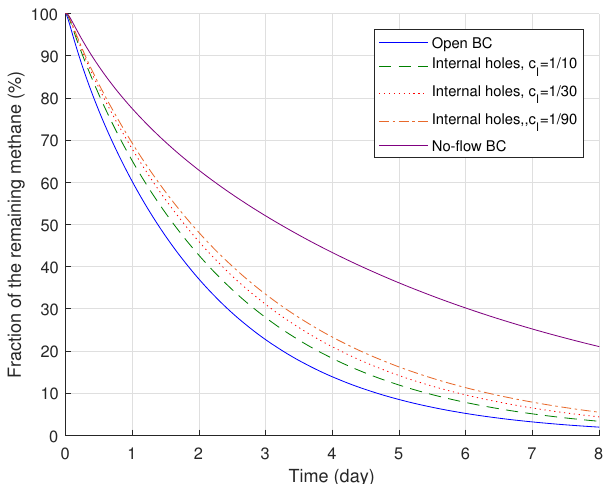
Figure 10. Degassing efficiency changes due to the boundary conditions for the cable conductor.